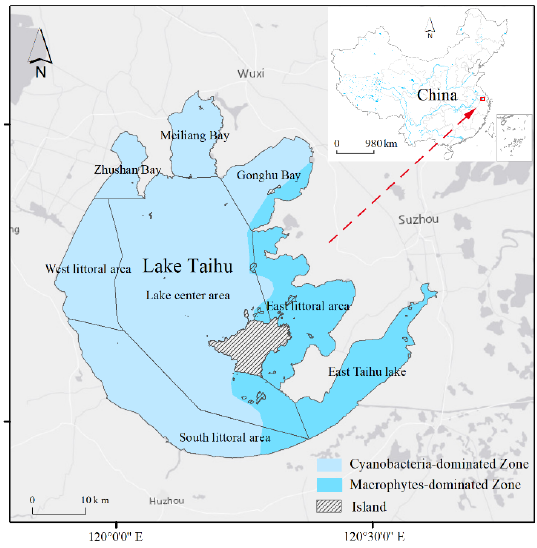
Figure 2. Location of Lake Taihu, China. The inset shows that the lake is divided into several lake segments conventionally. Traditionally, cyanobacteria-dominated water in most of the western part and eastern part is dominated by macrophytes.